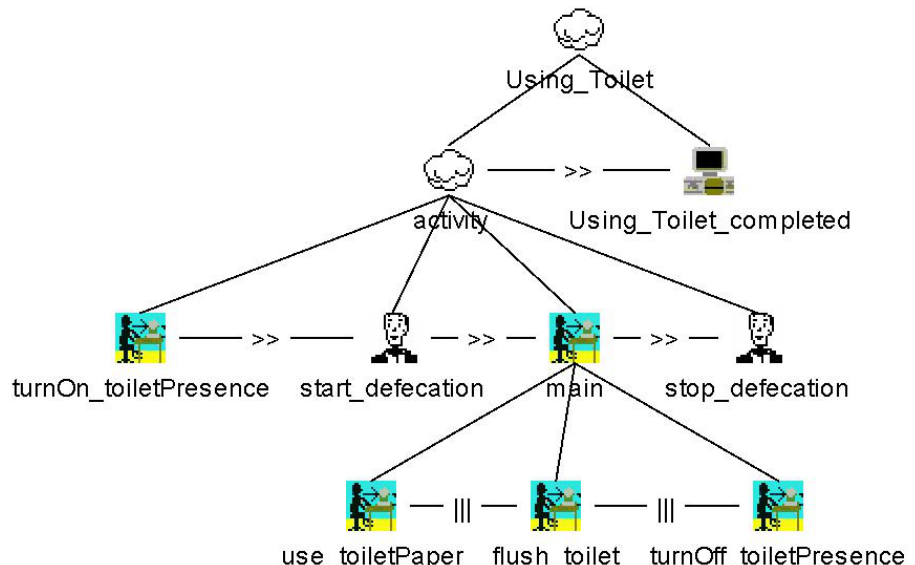
Figure 9. CTT model of the ADL “Using Toilet” (including all six possible